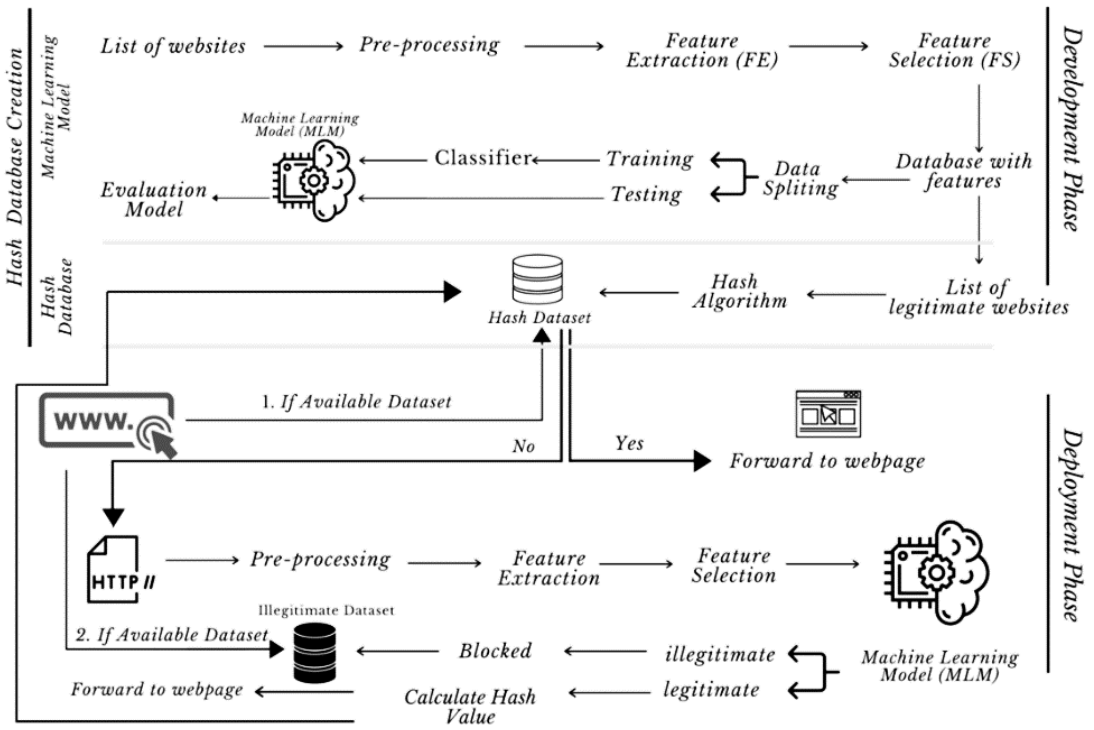
Figure 1. Proposed methodology.